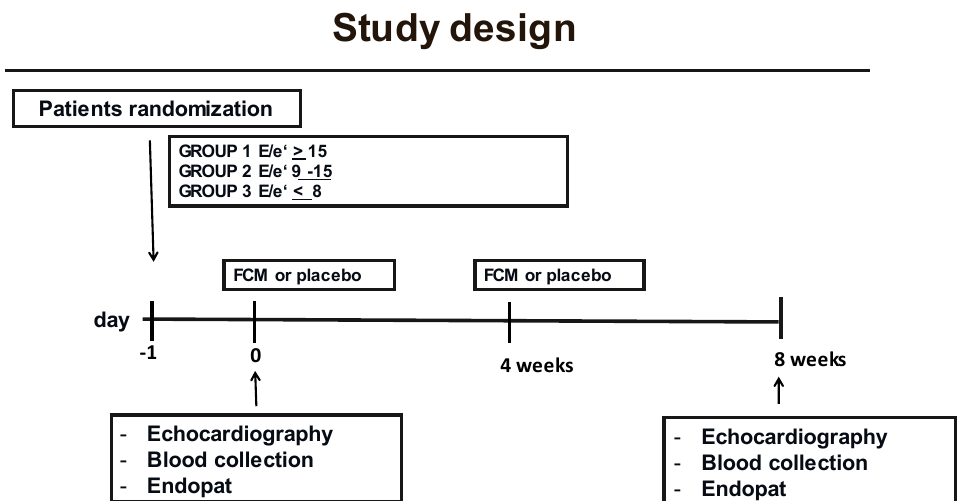
Figure 1. Study design. The multicentric, double-blind, randomized, placebo-controlled study was conducted on 64 subjects suffering from HFpEF classified according to the ESC Guidelines 2021.